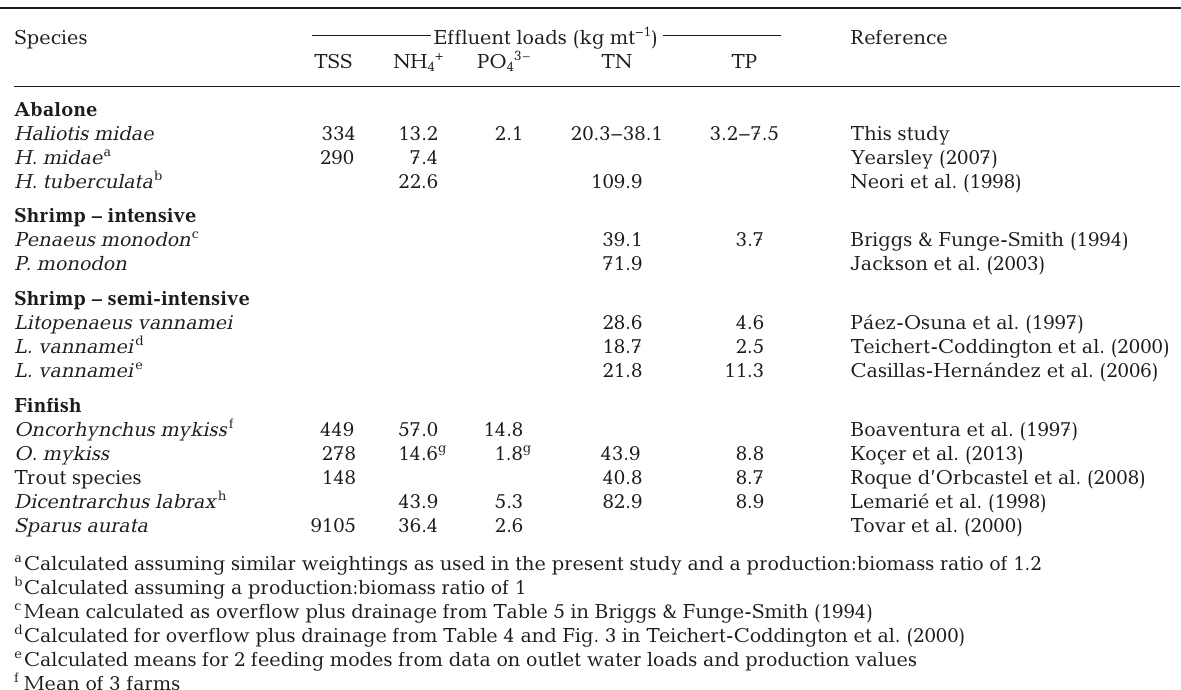
Table 5. Comparison of net discharges per metric tonne of production of total suspended solids (TSS), NH 4+ -N, PO 43− -P, total N (TN) and total P (TP) for some land-based aquaculture